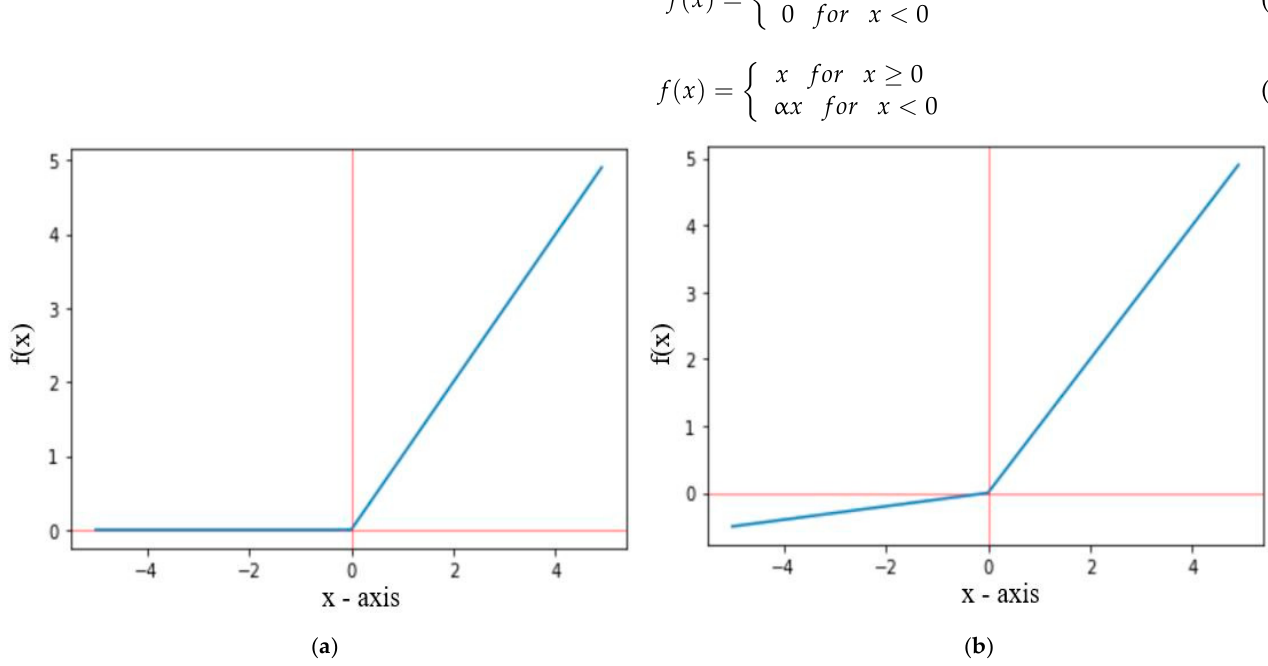
Figure 6. Graph representation of ( a ) ReLU and ( b ) LeakyReLU.